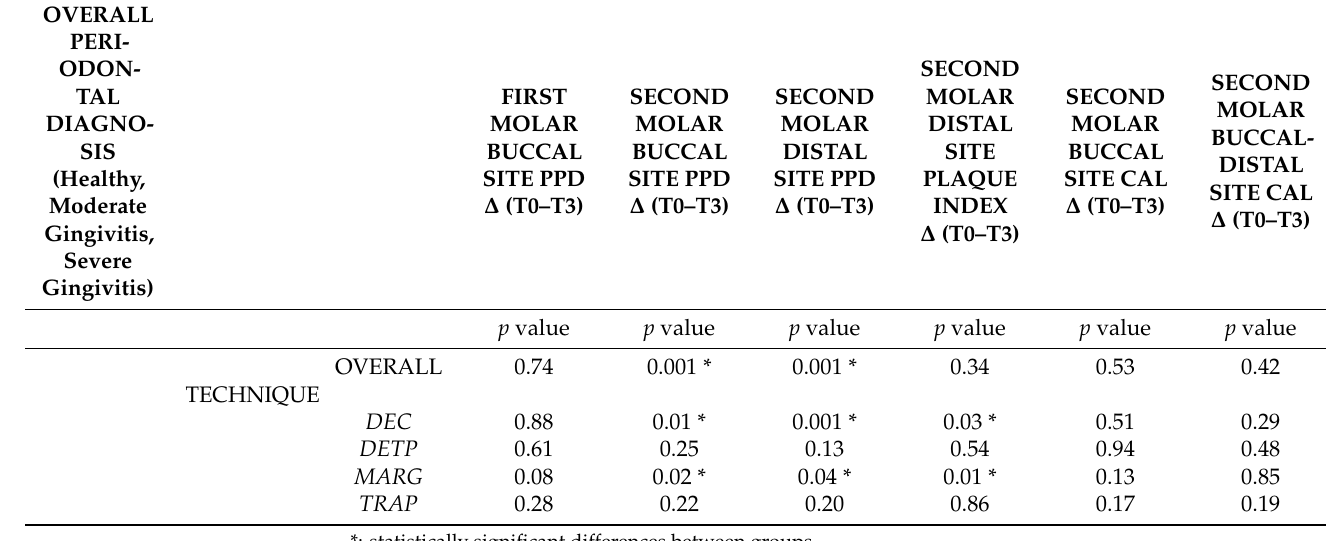
Table 2. Analysis of soft tissues indexes of periodontal healing between T0 and T3, according to pre-operative periodontal diagnosis, for overall sample and comparing different flaps techniques; p values are reported.